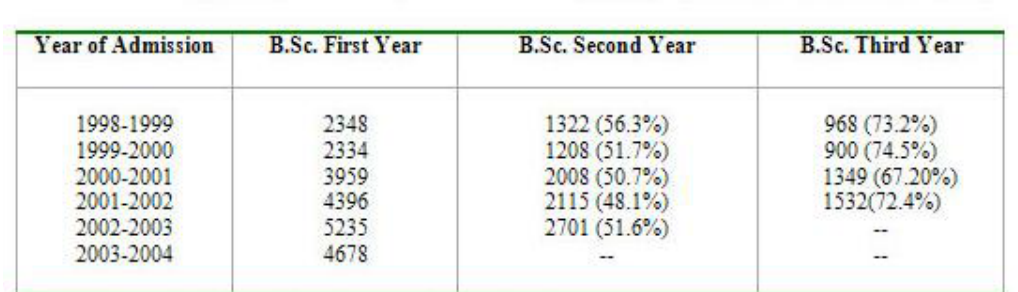
Table 1. Admission and Subsequent Registration Pattern for the Last Six